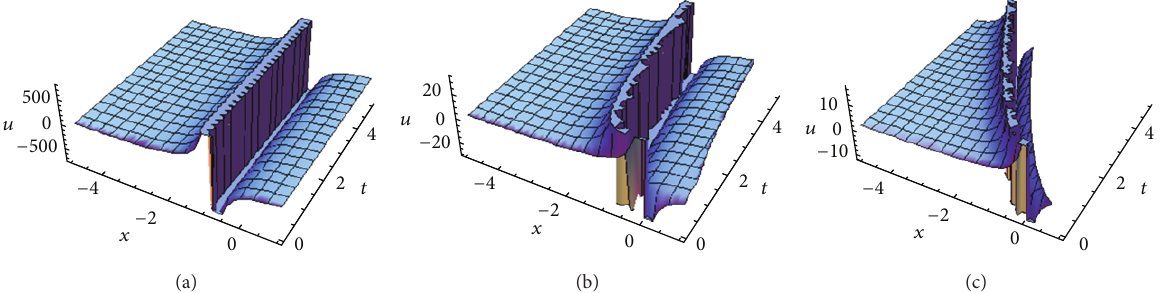
Figure 4: Graphics of the solution equation (60) corresponding to the values 𝛼 = 𝛽 = 0.01 , 𝛼 = 𝛽 = 0.25 , and 𝛼 = 𝛽 = 0.75 from left to right when 𝑎 1 = 𝑏 0 = 𝑏 1 = 𝑝 = 𝑘 = 1 , −5 < 𝑥 < 1 , and 0 < 𝑡 < 5